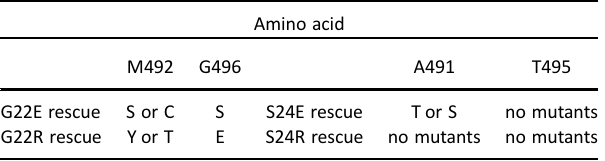
Table 4 . The rescue of glutamic acid or arginine mutants in TM1 by single amino acid mutations of